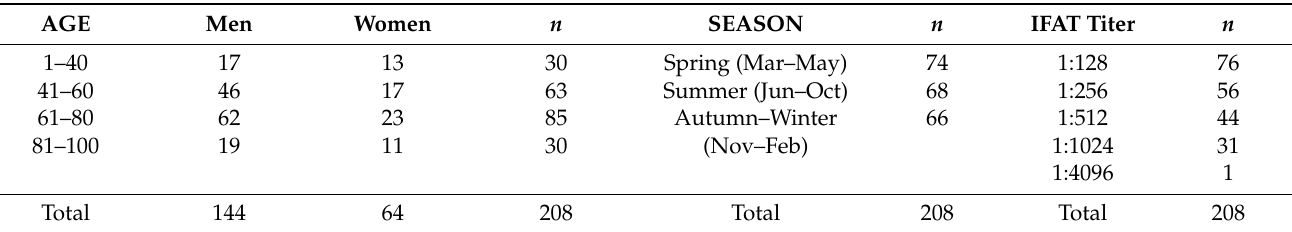
Table 4. Distribution of human cases considered as probable Q fever by age and gender, season, and IFAT titer.